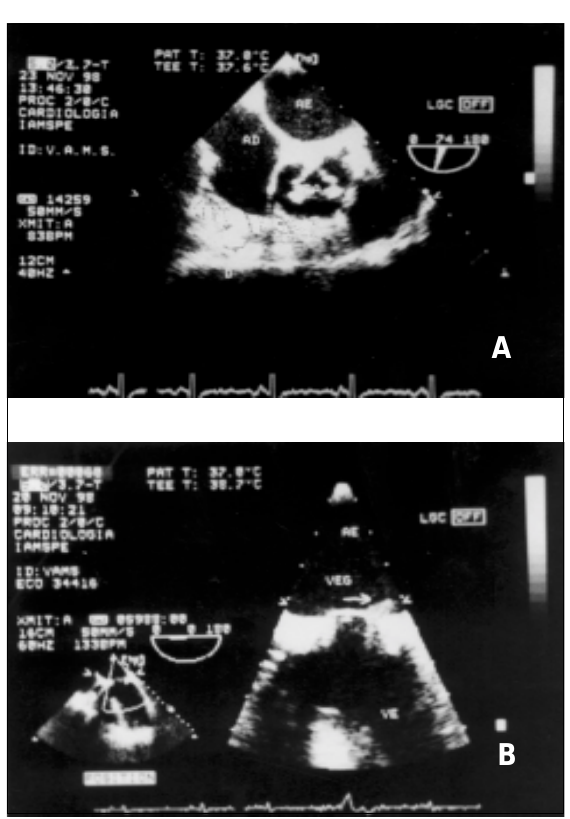
Fig. 1 - Ecocardiograma transtorácico revelando: A) prótese biológi- ca em posição aórtica com vegetações em suas